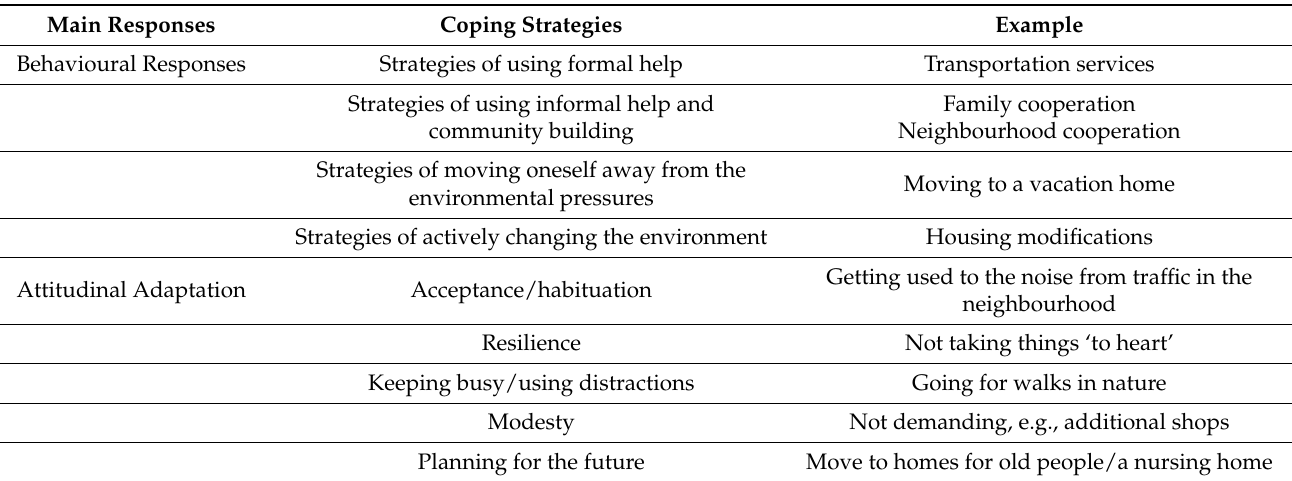
Table 2. Main coping strategies of older people in urban neighbourhoods in